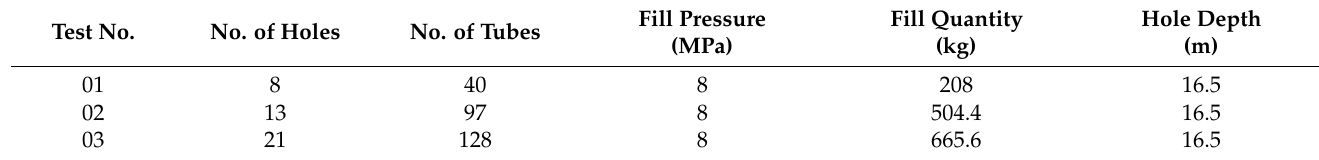
Table 3. L-CDRB test parameters.